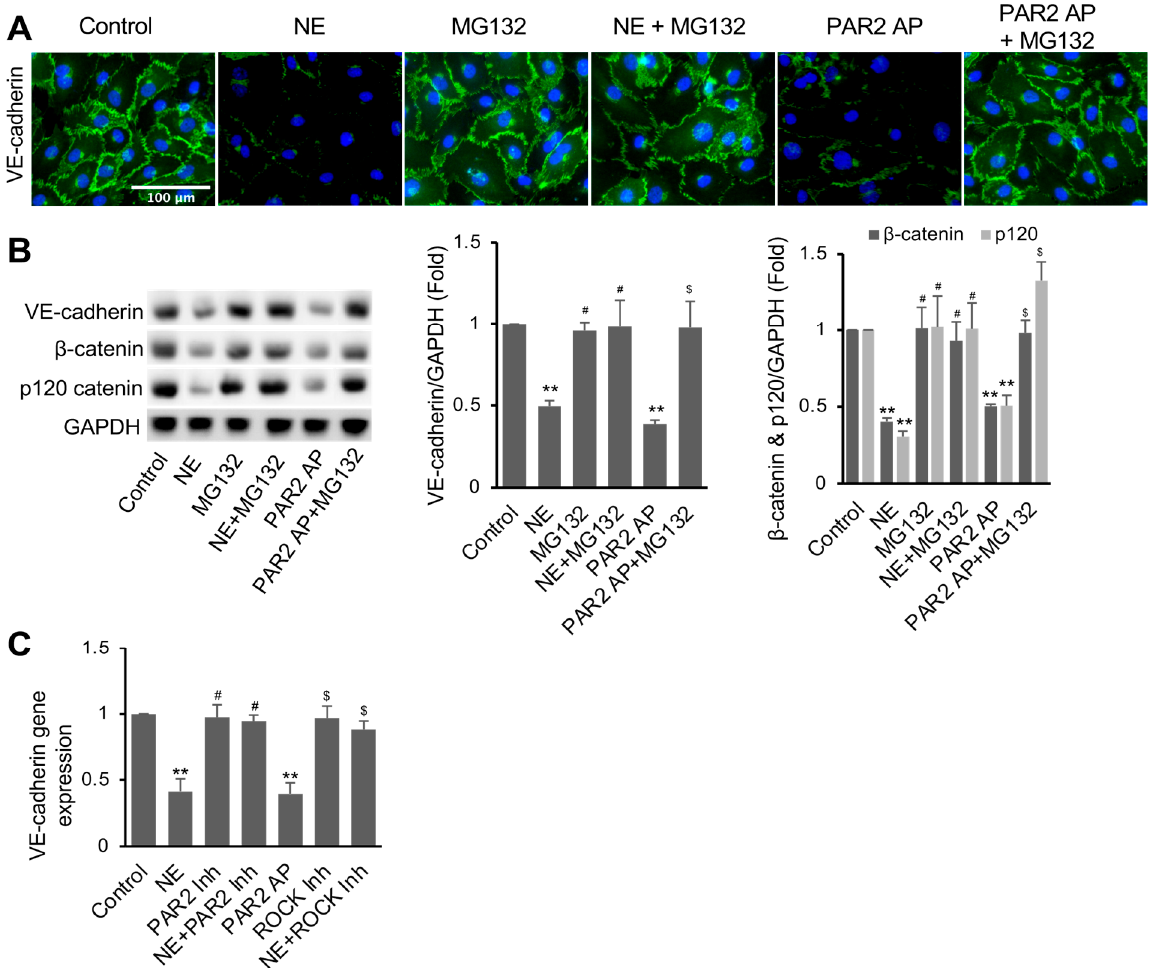
Figure 4. Inhibition of proteasome activity reversed NE-induced VE-cadherin degradation and permeability in hECs. Cells were treated with or without proteasome inhibitor MG132 (5 μ M) for 2 h before adding NE (20 nM) or PAR2 agonist (Par2-AP, 7.5 μ M) for 16 h, as indicated. Then, cells were used for immunofluorescence imaging of VE-cadherin and Western blot analysis. ( A ) VE-cadherin fluorescence images (green) are representative of three independent experiments (scale bar, 100 μ m). ( B ) Western blot images and quantification showing VE-cadherin, β -catenin, and p120-catenin in hECs. ( C ) Gene expression of VE-cadherin in hECs treated with NE (20 nM) or PAR2 agonist (Par2-AP, 7.5 μ M) in the presence or absence of ROCK inhibitor (Y27632, 5 μ M) for 16 h. RT-PCR was used for quantifying gene expression levels of VE-cadherin normalized to 36B4 for each sample. All data are expressed as mean ± SD of three independent experiments. ** p < 0.01 vs. vehicle control, # p < 0.05 vs. NE group, $ p < 0.05 vs. PAR2-AP. PAR2-AP: PAR2 agonist (PAR2 (I-6) amide trifluroacetate salt) (7.5 μ M), ROCK Inh: ROCK inhibitor. See also Figure S4.